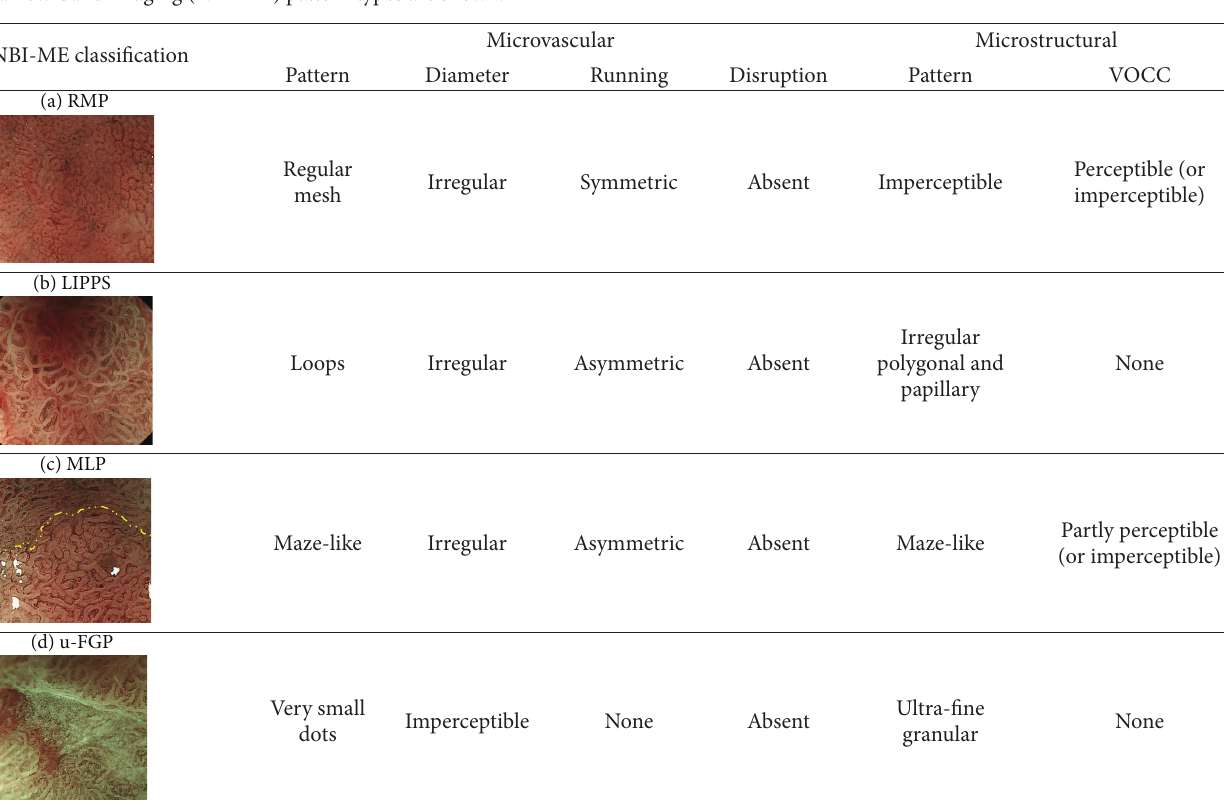
Table 2: Summary of the microvascular and microstructural items and high-magnification views of the four magnifying endoscopy with narrow-band imaging (NBI-ME) pattern types are